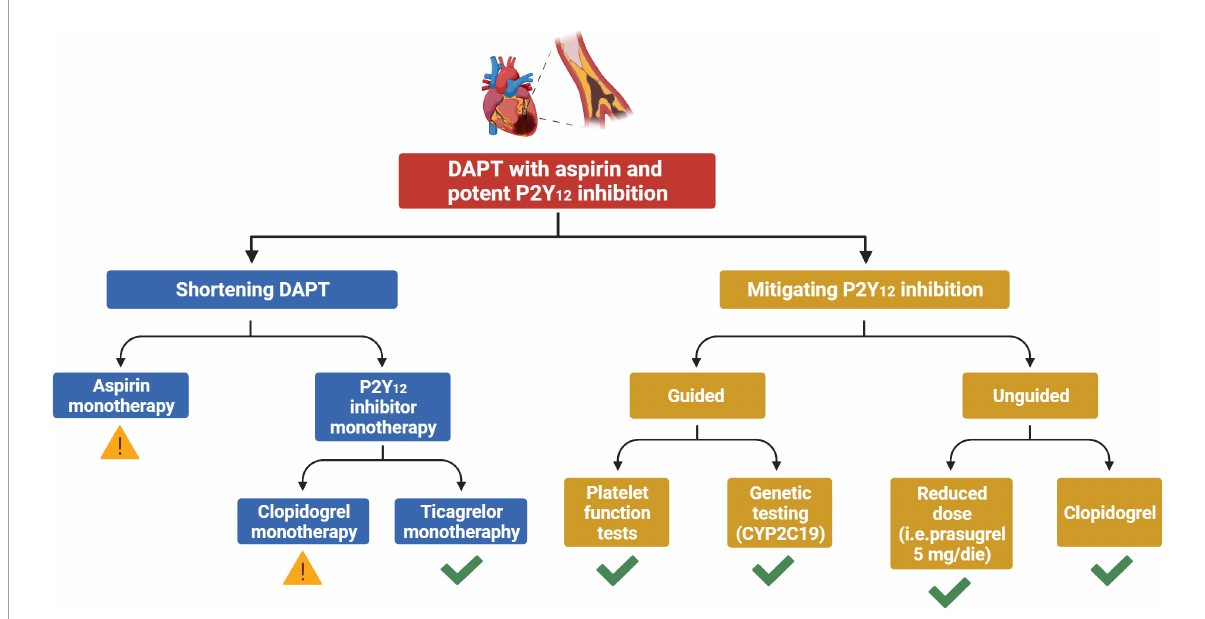
FIGURE1 Strategies for a de-escalation of antiplatelet therapy among patients with ACS undergoing PCI. Yellow exclamation mark, strategy associated with possible increased ischemic risk. Green check, strategy not associated with any trade-off in ischemic events. ACS, acute coronary syndrome; DAPT, dual antiplatelet therapy; CYP, cytochrome